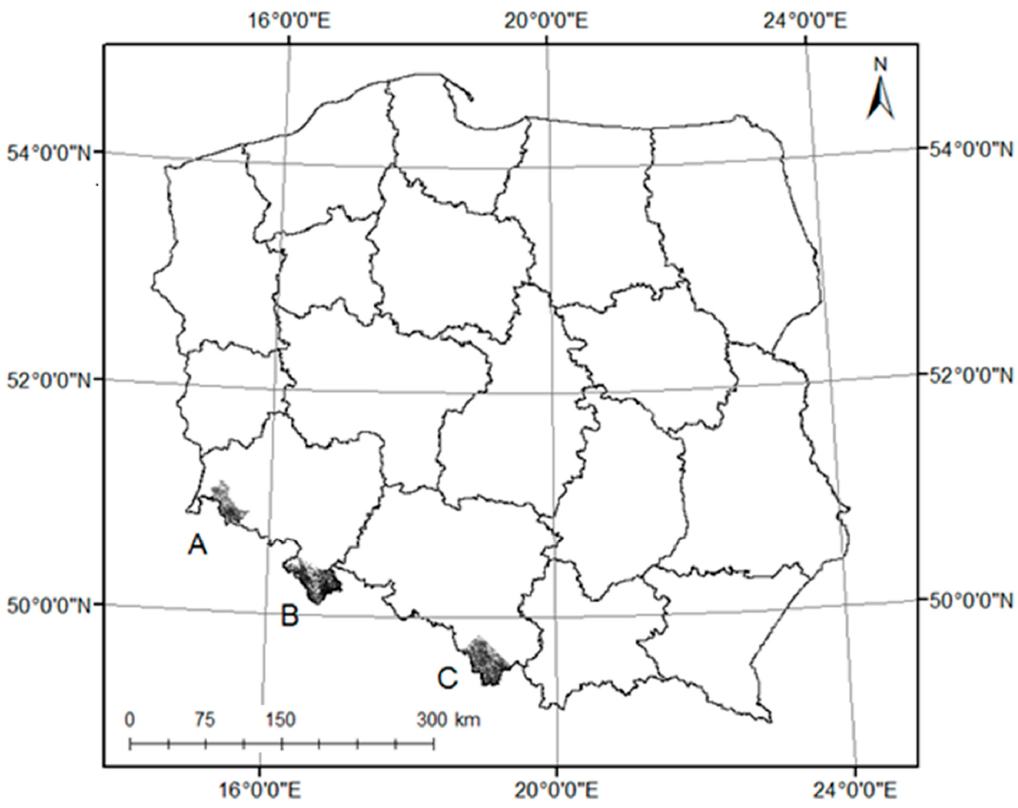
Figure 1. The areas of investigation.